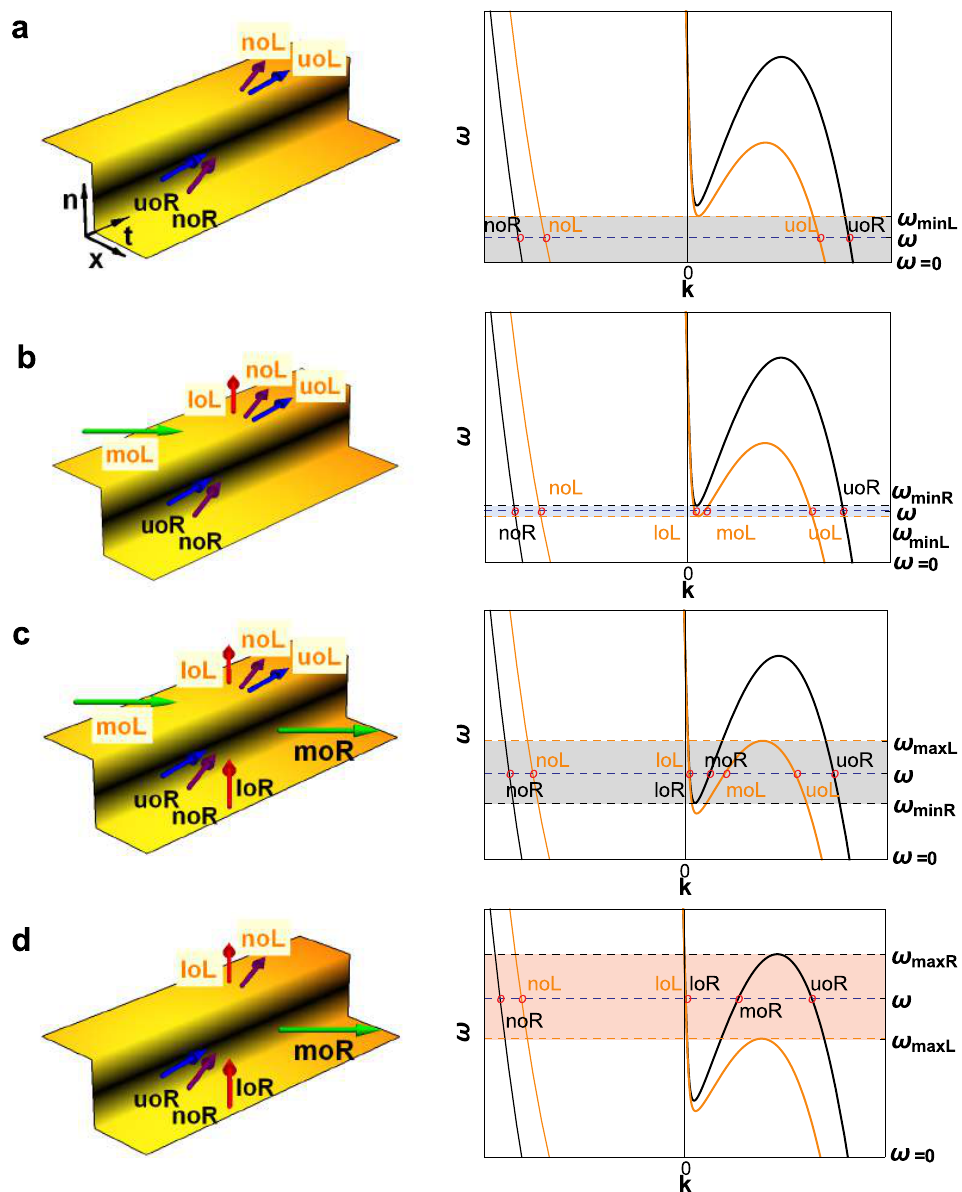
Figure 1: Possible kinematic scenarios at the RIF. Time (left) and frequency (right) illustrations of propagating modes are shown for different comoving frequencies ω ( a - d ). The black (orange) dispersion curve corresponds to the low (high) in- dex region. Single-frequency modes of ω are identified by intersections with the blue dashed